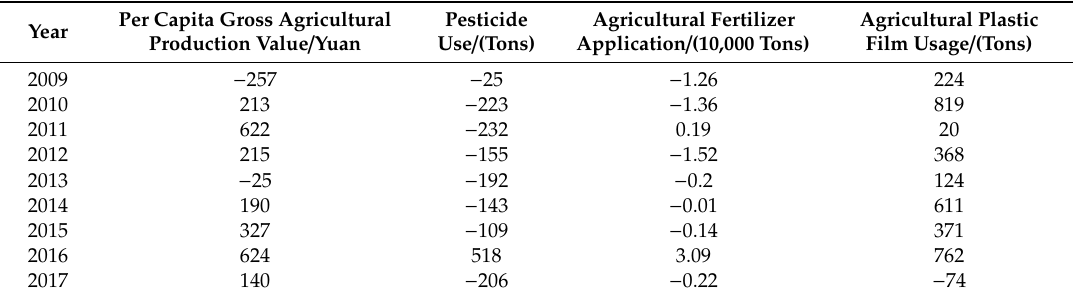
Table 2. Changed value for the raw data for the selected indicators in each year compared with the previous year.